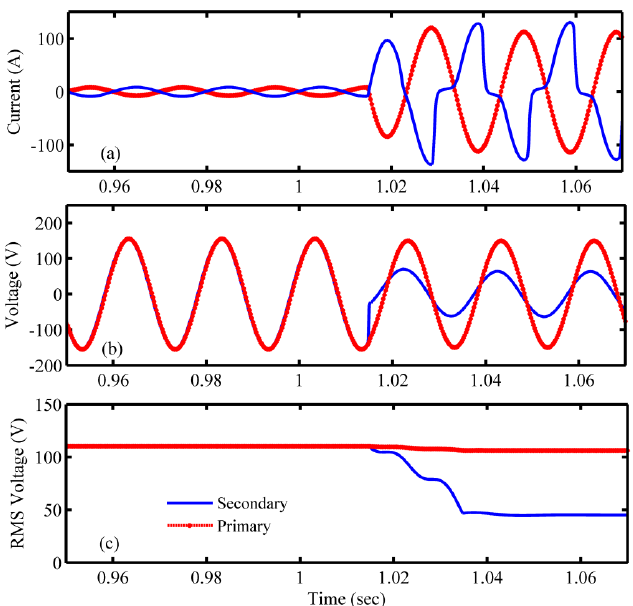
Fig. 9. External condition: (a) Current waveform, (b) Voltage waveform, (c) RMS value of voltages.